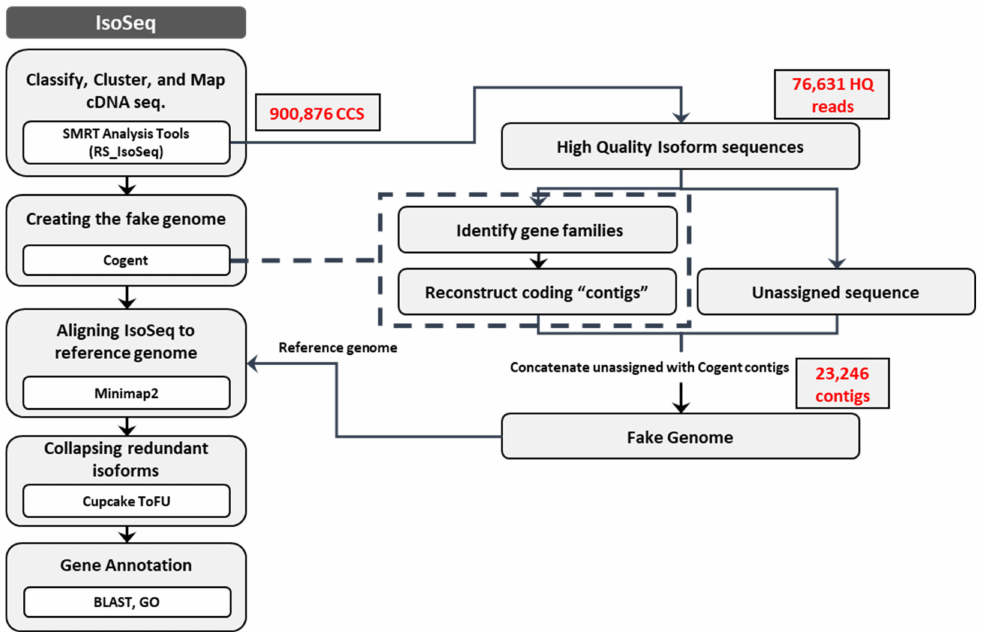
Figure 2. Schematic representation of pipeline to isoforms of full-length complementary DNA (cDNA) sequence used for B. koreana .